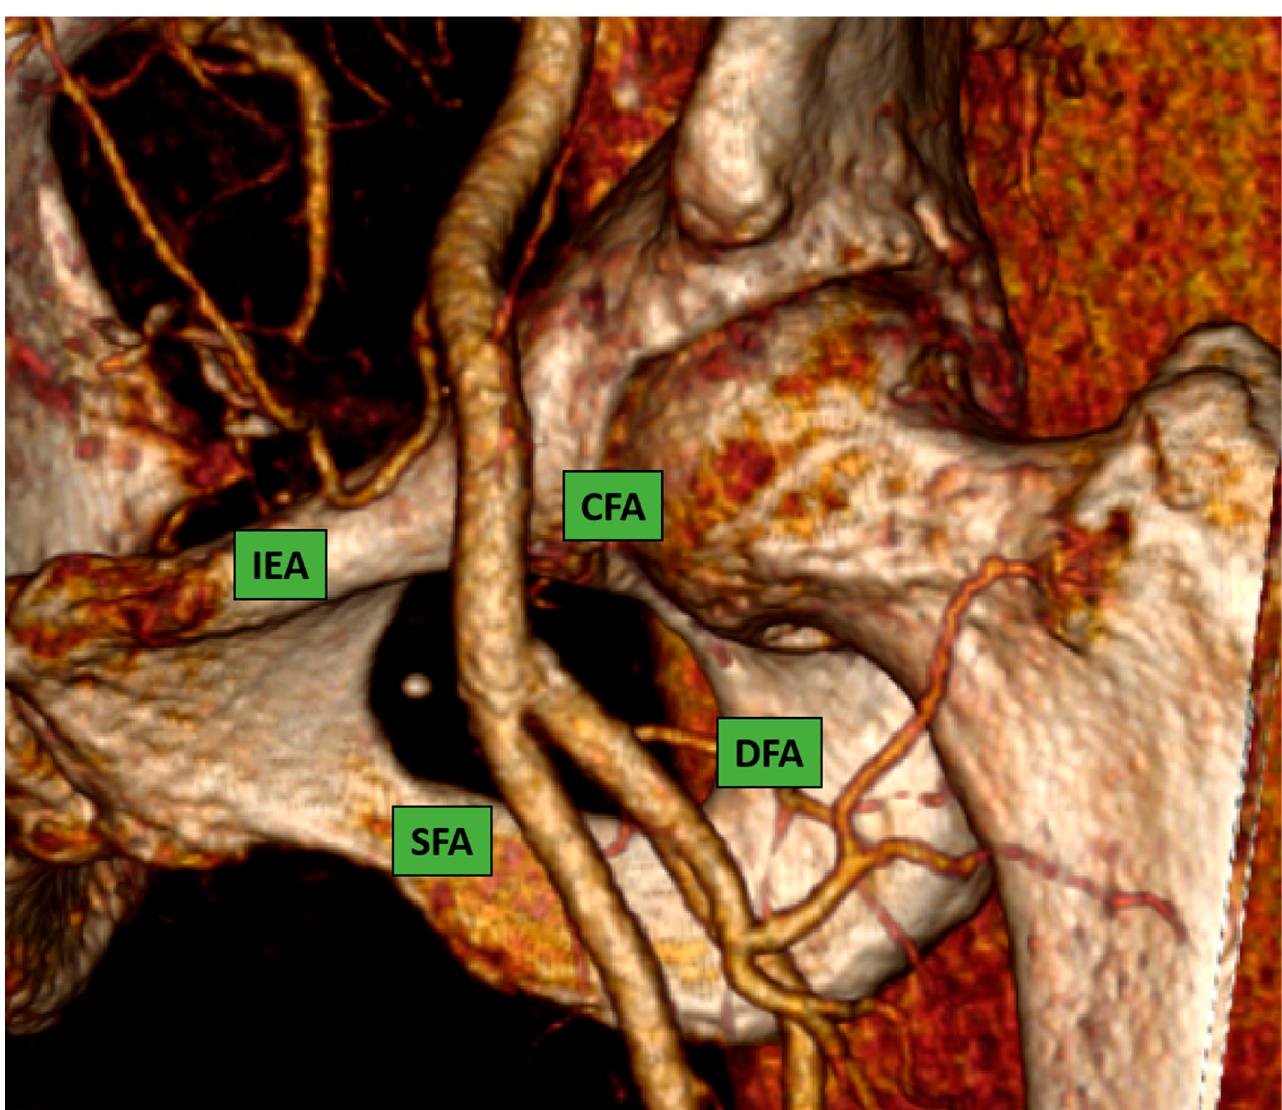
Figure 1. Common femoral artery and bifurcation into superficial and deep femoral artery. 3D reconstruction image from computed-tomography scan (CT-scan).